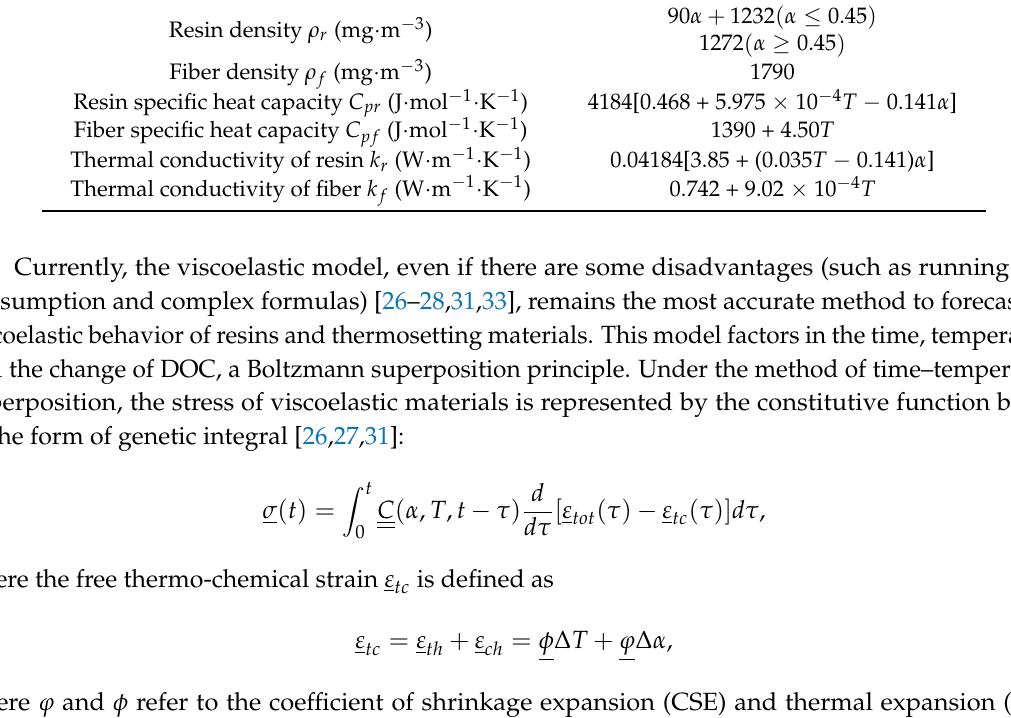
Table 2. Thermo-physical properties of AS4 carbon fiber and 3501-6 epoxy resin [1,2,33].